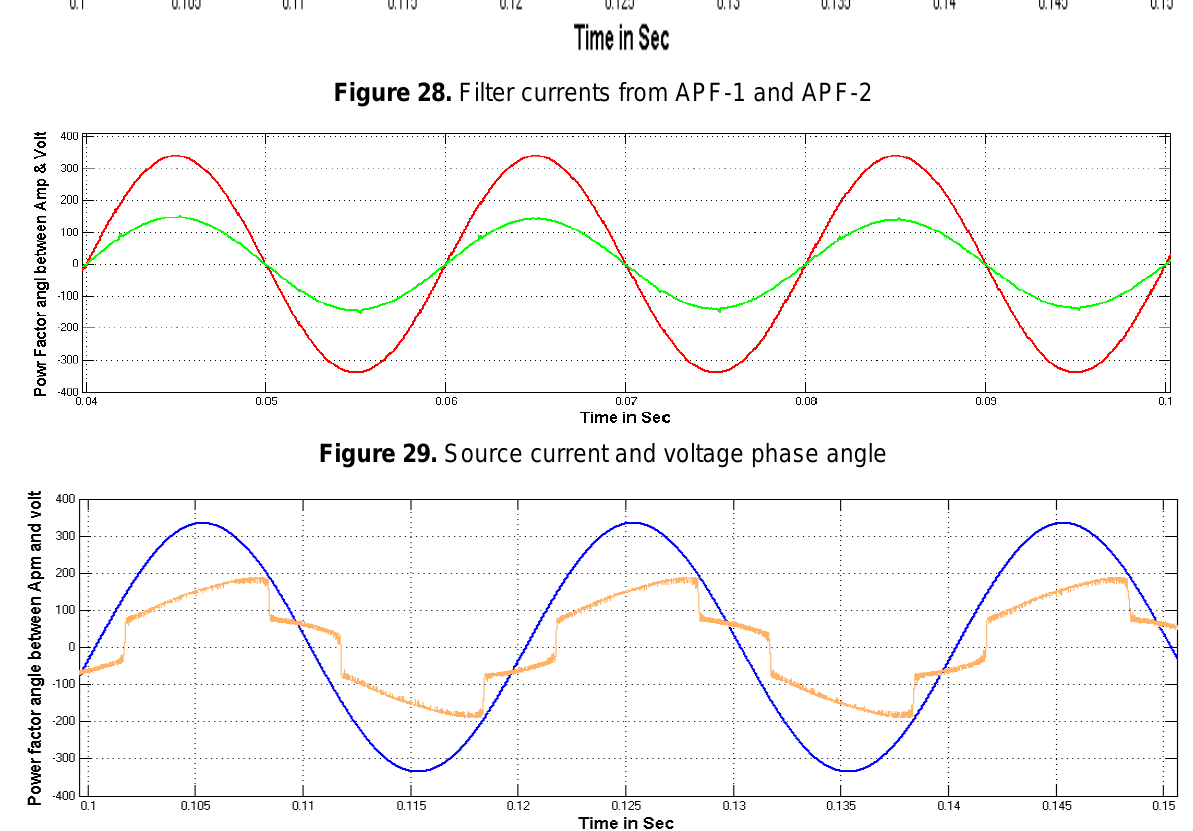
Figure 30. Load current and voltage phase